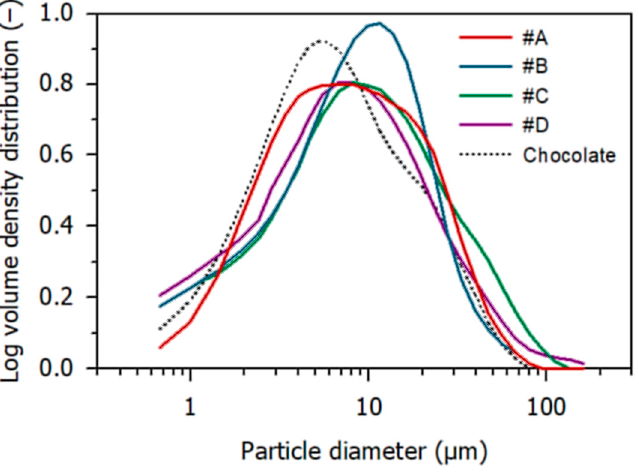
Figure 1. Particle size distributions of nougat samples #A–#D and of the chocolate used for the preparation of the layer models.